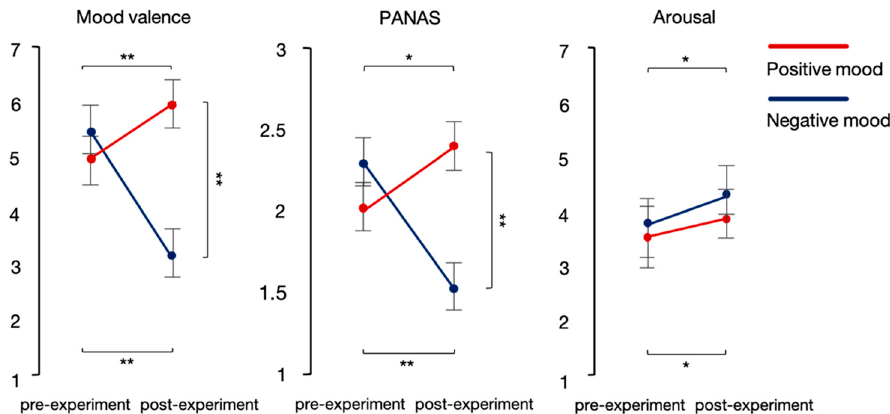
Figure 2. Mood ratings for the mood valence scale ( left ), the PANAS ( middle ), and the arousal scale ( right ) with CI of 95% (** p < 0.001, * p < 0.01). Table 6. Mood Ratings from PANAS and the mood valence and arousal Scales (with 95% CI). Mood Valence PANAS Arousal Positive mood condition